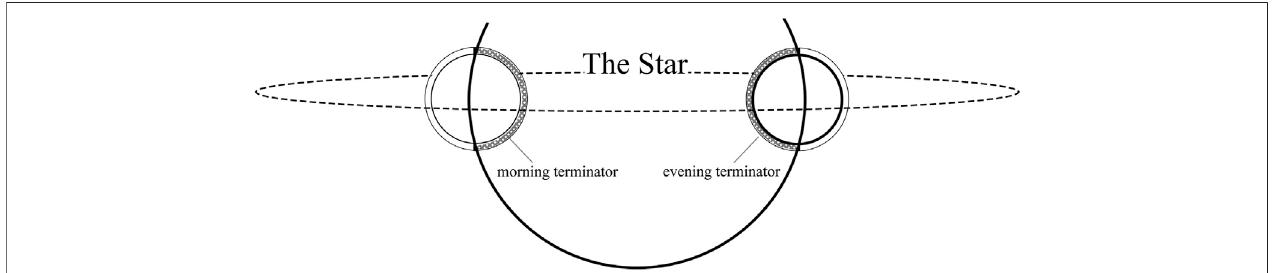
FIGURE1| Theorbitalgeometryofatransitingexoplanetsystem.Thedashedlineistheplanetaryorbit,thethicksolidlineistheedgeofthestar,andtwophasesof the planet during the ingress and egress are shown. The asymmetry between the transit depth of the morning terminator during the ingress and the transit depth of the evening terminator during the egress leads to a distorted light curve.